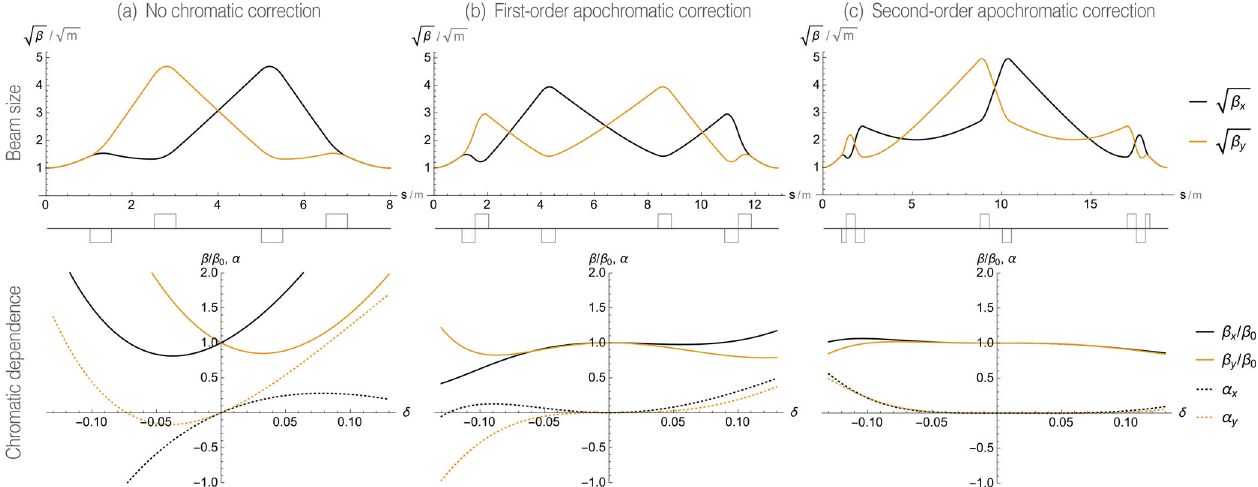
ffiffiffi p β (proportional to rms beam size) vs beam line axis s , and chromatic dependence of β ð δ Þ and α ð δ Þ vs δ , shown for different orders of apochromatic focusing. All solutions satisfy initial and final Twiss parameters β ¼ 1 m and α ¼ 0 in both planes, with a 1 m drift before and after the first and last quadrupoles respectively. The chromatic dependence of the lattice flattens progressively with higher orders of apochromatic focusing; No chromatic correction (a) results in chromatic amplitude W ≠ 0 (a slope) at nominal energy δ ¼ 0 , whereas first order correction (b) removes this chromatic amplitude W ¼ 0 (no slope), and second order correction (c) flattens it further by removing second order chromatic errors (curvature) around δ ¼ 0 . Overall, the chromatic dependence can be decreased at the cost of longer lattices with more quadrupoles, where the appropriate order of the correction is determined by the energy spread of the